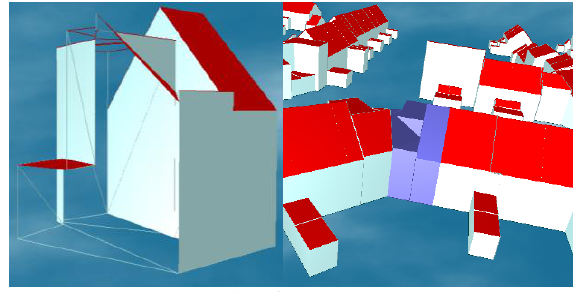
Figure 16. WallSurface splitting a building